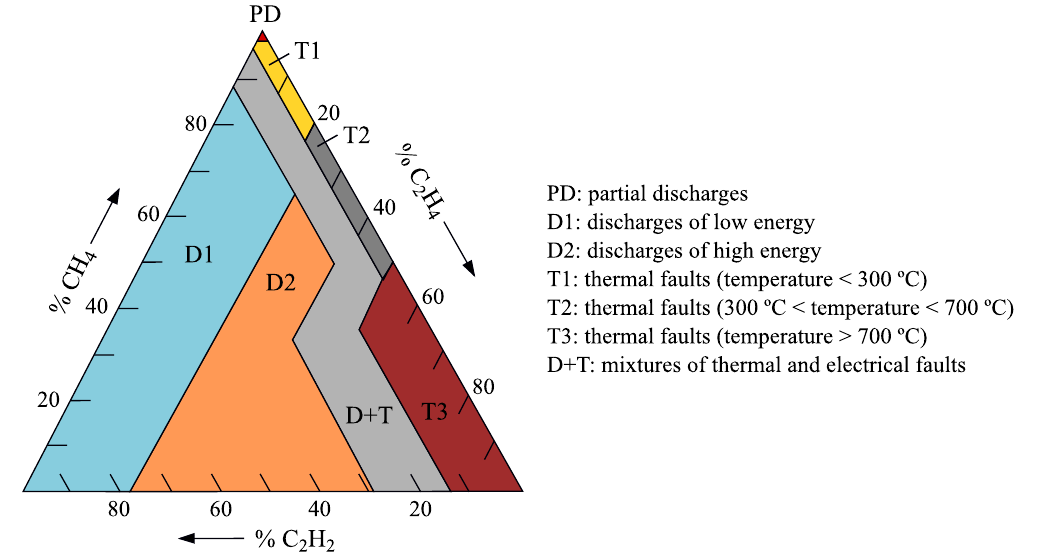
Figure 5. Duval Triangle and list of faults detectable by DGA